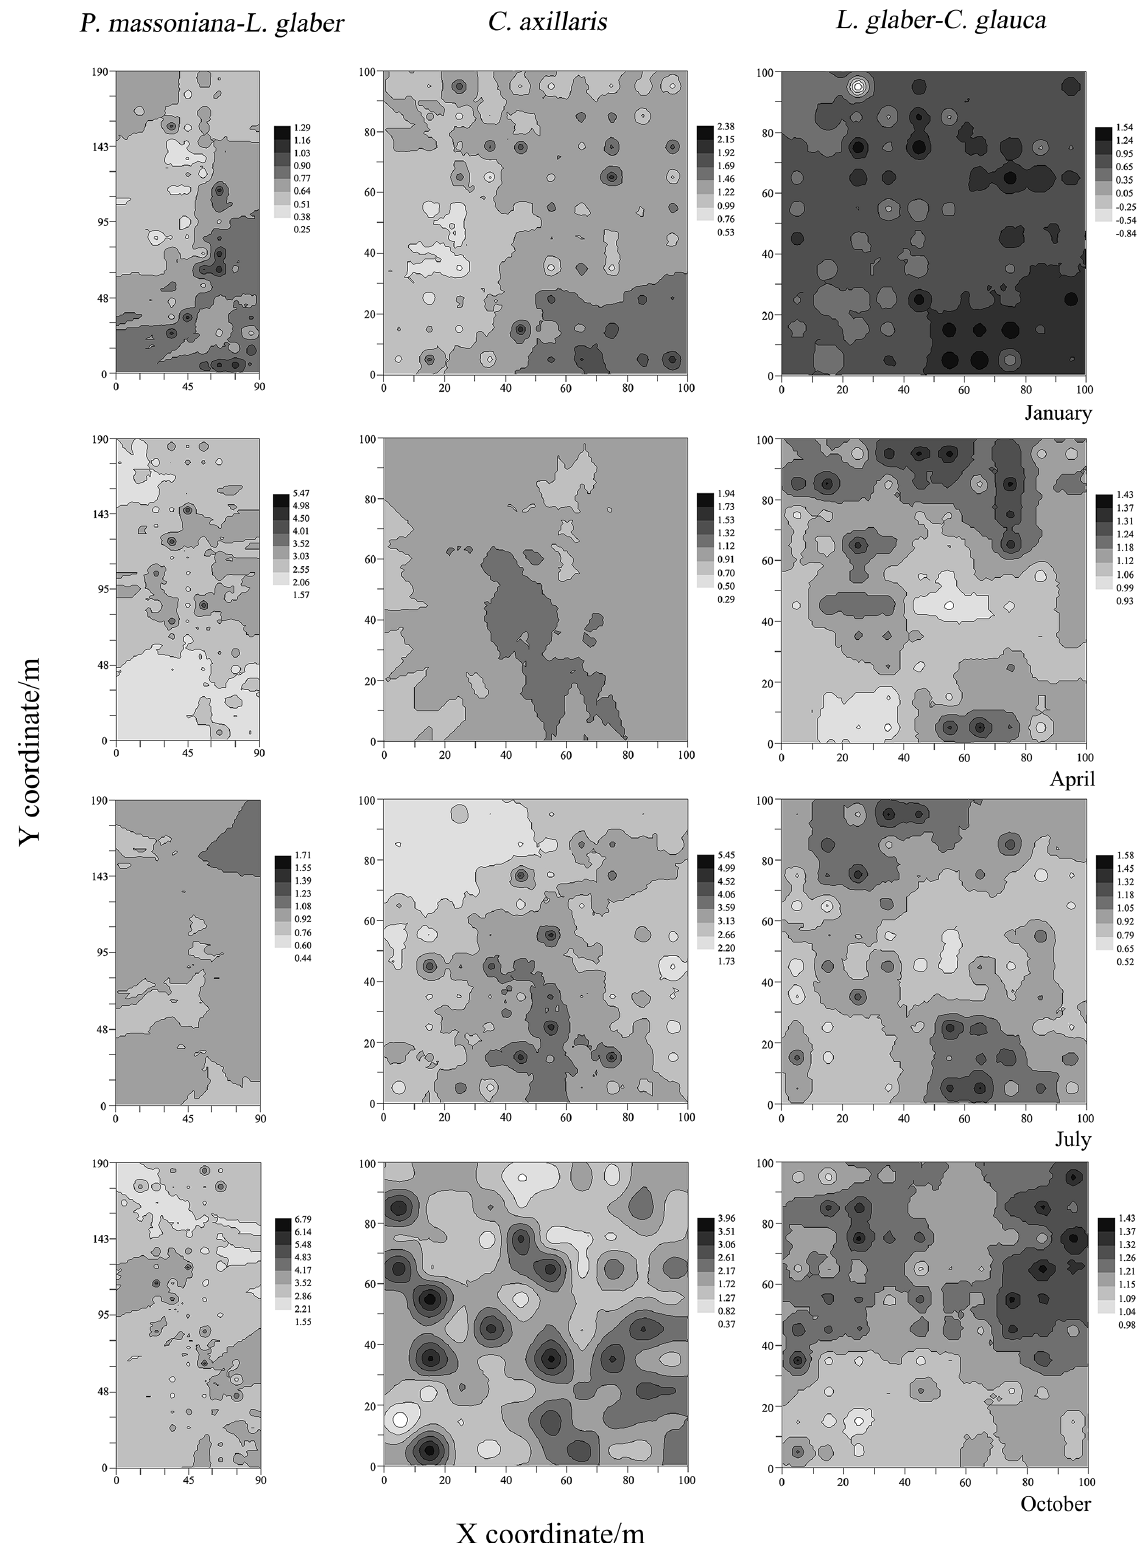
Figure 2. Spatial heterogeneity map of LAI values interpolated through ordinary Kriging method for P. massoniana – L. glaber , C. axillaris , and L. glaber – C. glauca